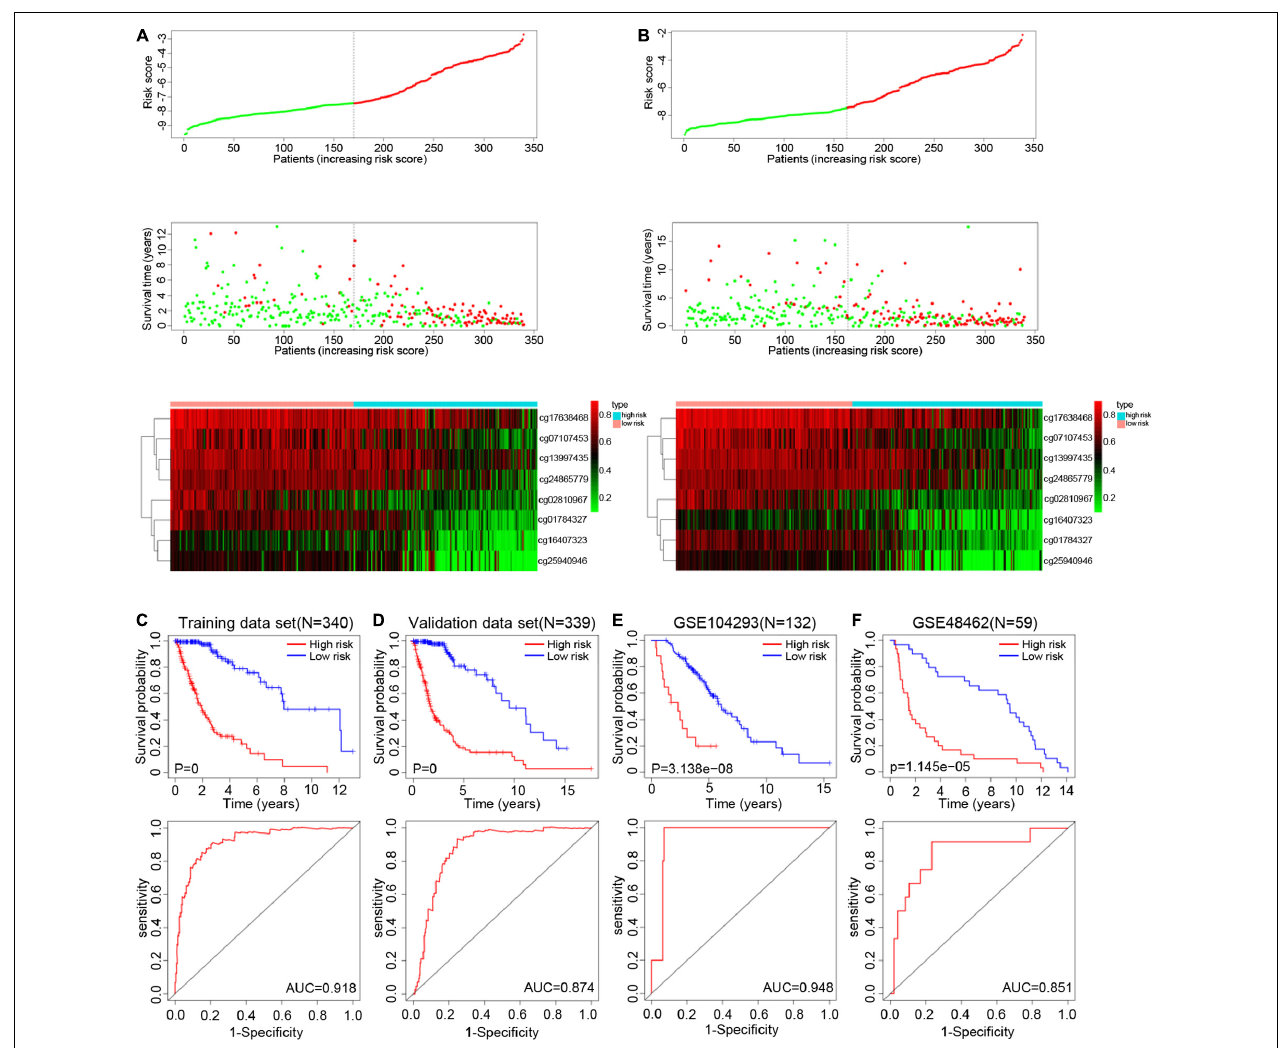
FIGURE 4 | Distribution of the risk score, survival status, and β values of methylation sites in the training set (A) and testing set (B) . K-M survival curves along with the log-rank test and ROC analysis to evaluate performance of this risk score formula in training set (C) , testing set (D) , GSE104293 (E) , and GSE48462 (F) . Abbreviations: K-M, Kaplan-Meier; ROC, receiver operating characteristic; AUC, area under the